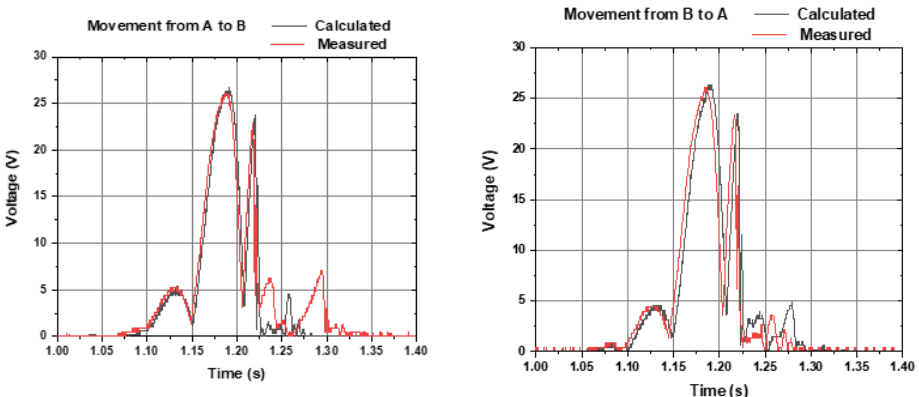
Figure 8. Calculated voltage (grey line) and experimentally measured voltage (red line) of the output, within a freefall movement from Coil A to Coil B ( left graph ) and from Coil B to Coil A ( right graph ). Each coil voltage was rectified and connected in series.